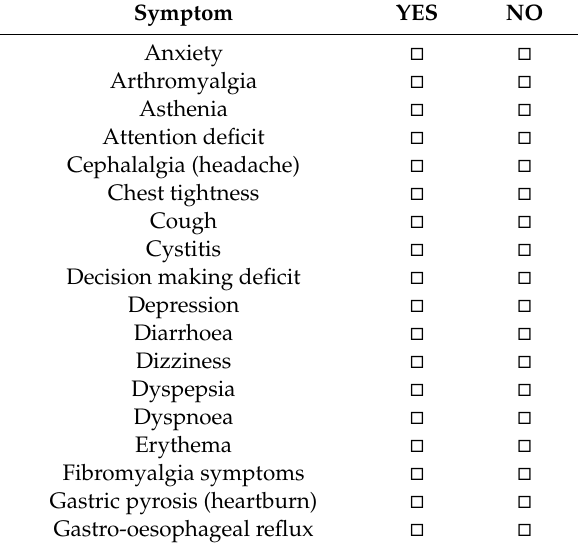
Table 1. Checklist of